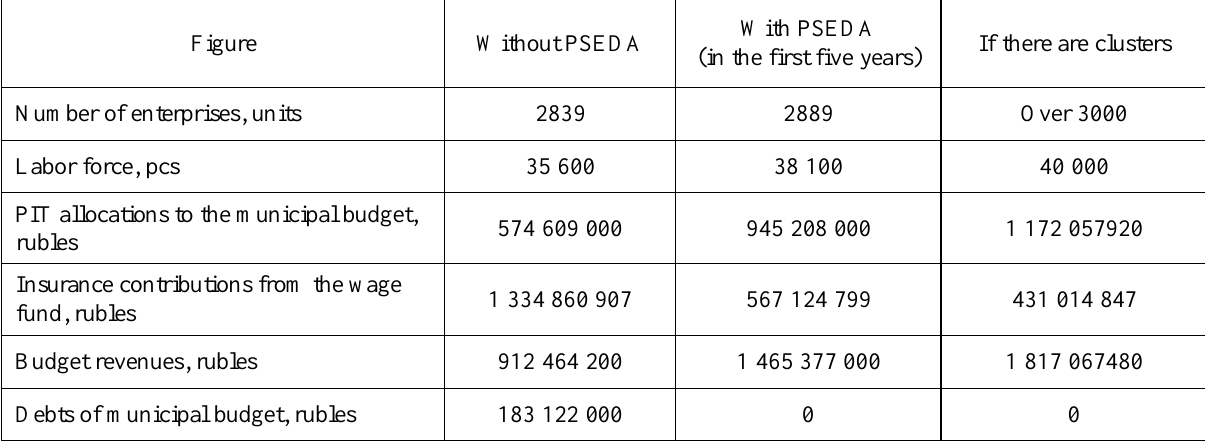
Table 2. Estimated figures of cluster formation under PSEDA in the mono-industry town of Yurga, Kemerovo region